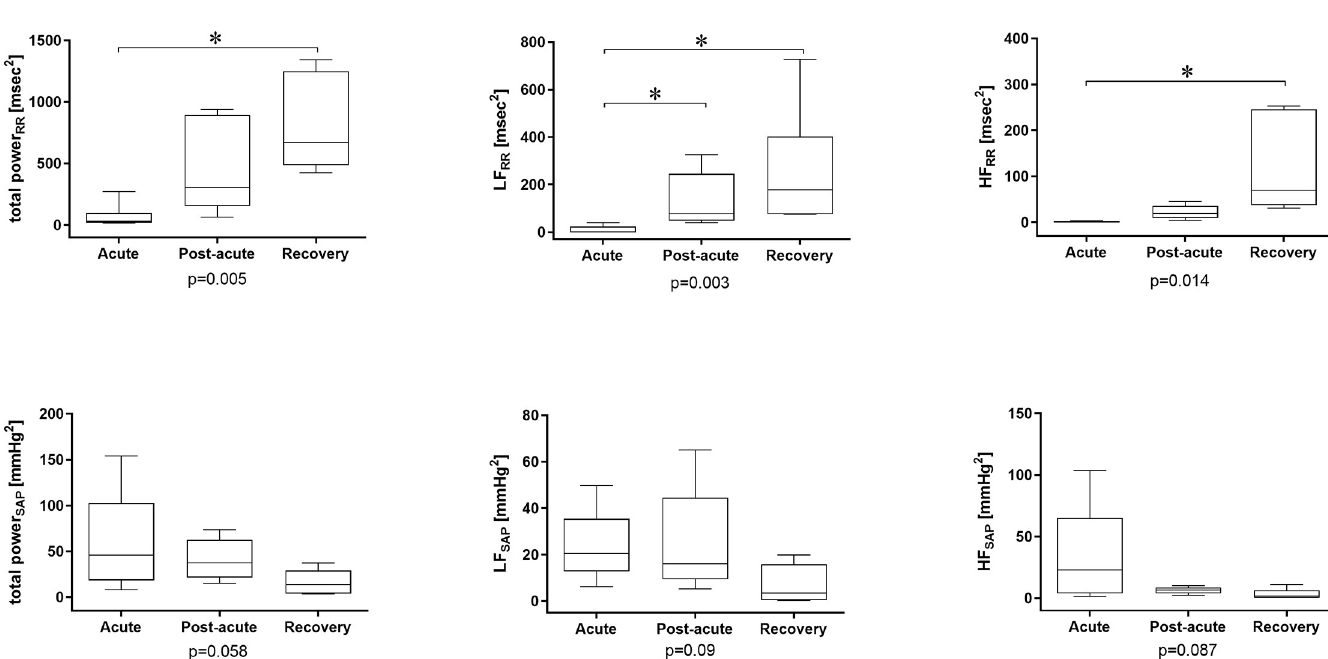
Fig 1. Heart Rate (RR) and Systolic Arterial Pressure (SAP) variability analysis results in the frequency domain. RR, heart period; SAP, systolic arterial pressure; HF, high frequency band of the power spectrum; LF, low frequency band of the power spectrum. � p < 0.05 for post-hoc analysis of ANOVA on